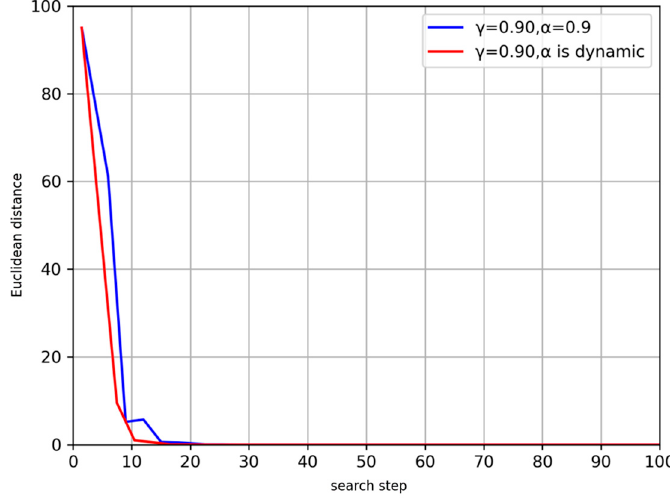
Figure 13. Q-matrix convergence before and after updating learning factors dynamically.